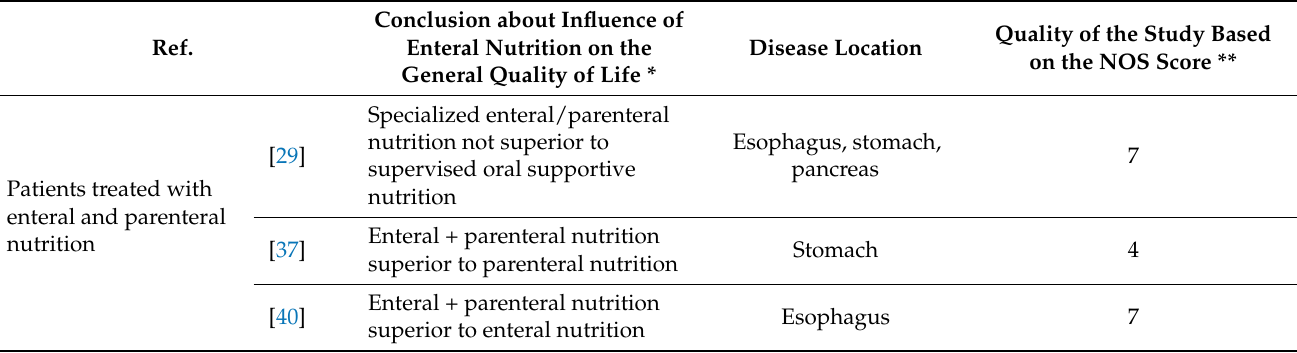
Table 9. The summary of conclusions from the studies comparing patients treated with enteral and parenteral nutrition, with various methods of enteral nutrition, and with enteral nutrition of various contents, included in the systematic review accompanied by the Newcastle–Ottawa Scale (NOS)